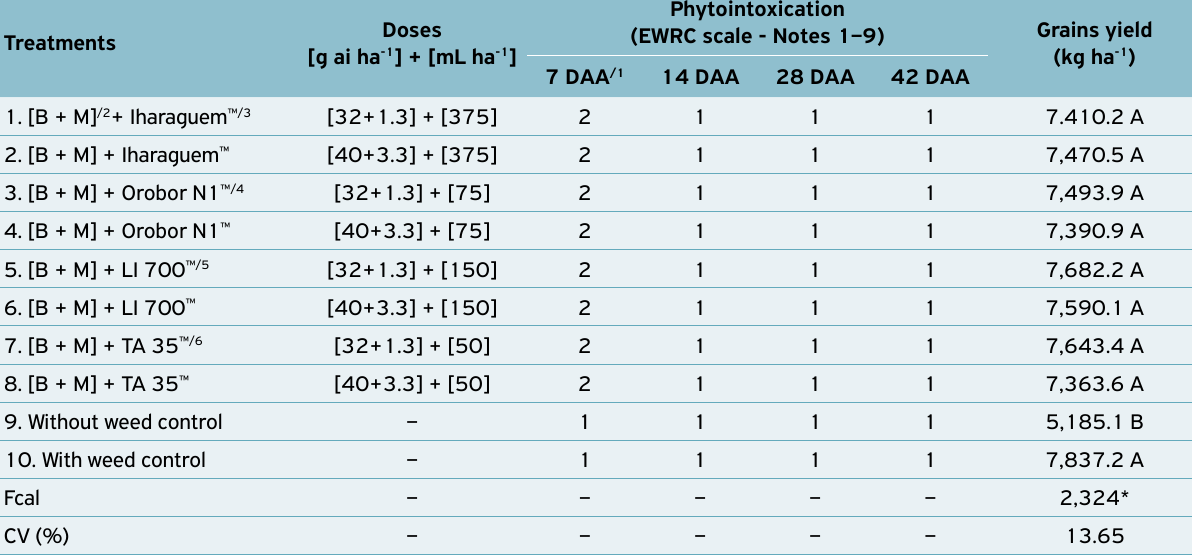
Table 3. Phytointoxication (European Weed Research Council — EWRC scale) and grains yield of irrigated rice crop (cultivar Epagri 108), subjected to the application, in post-emergence, of the in-tank mixture of bispyribac-sodium + metsulfuron-methyl [B + M].